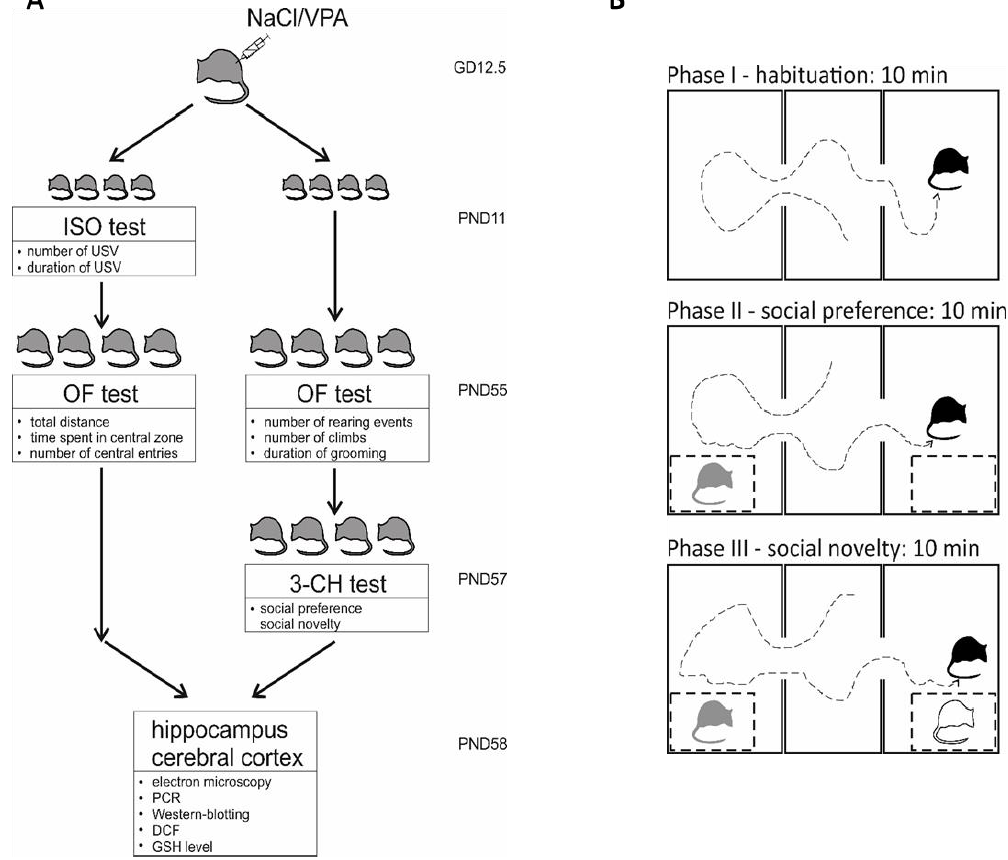
Figure 11. Experimental design. (A) Pregnant Wistar rats were injected at gestation day 12.5 (GD 12.5) with NaCl or VPA (450 mg/kg b.w.). One group of offspring rats (males and females) was subjected to an ISO test at postnatal day 11 (PND 11) and then to an Open-field test (males only) at PND 55. Other groups of offspring rats (males) was subjected to Open-field test at PND 55 and then to a 3-chamber test at PND 57. All offspring rats were euthanized at PND 58; tissue samples from the hippocampus and cerebral cortex were collected and used for biochemical, immunochemical, genetic, and microscopic analysis. (B) Design of the 3-chamber test. A detailed description is included in the behavioural analysis section.